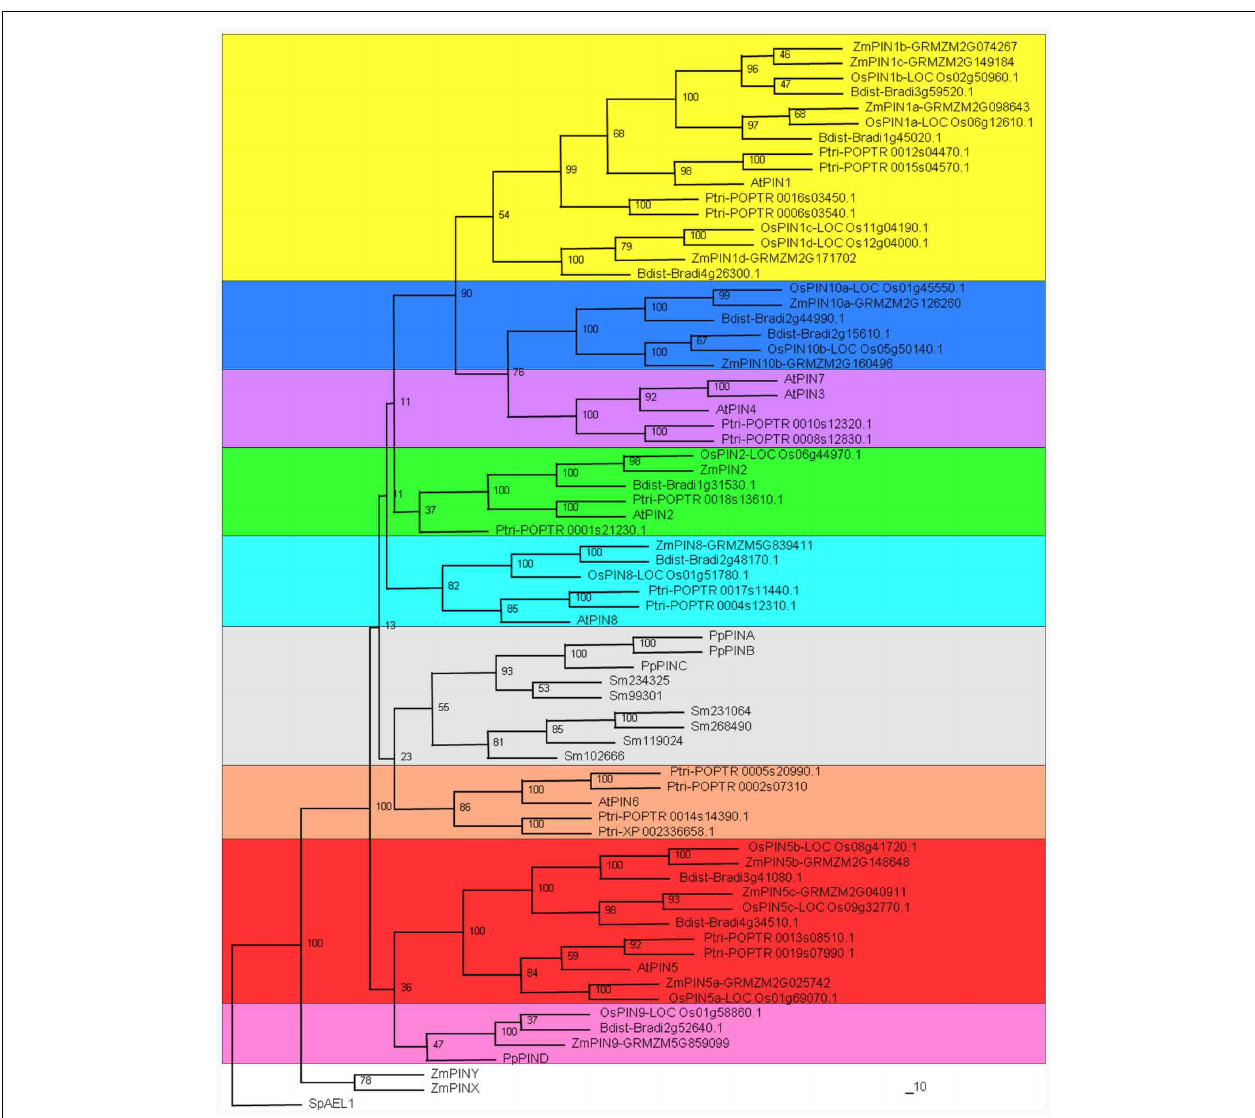
FIGURE 1 | Phylogenetic analysis of PIN auxin efflux carriers from Zea mays , Arabidopsis thaliana , Oryza sativa , Brachypodium distachyon , Populus trichocarpa , Physcomitrella patens , and Selaginella moellendorffii . The phylogenetic analysis between newly identified maize PIN proteins and PINs of eudicots and monocots, summarizes the evolutionary relationships among the 70 members of the PIN protein family. PIN protein sequences of Z. mays ( Zm ), A. thaliana ( At ), P. trichocarpa ( Ptri ), O. sativa ( Os ), B. distachyon ( Bdist ), P. patens ( Pp ), and S. moellendorffii ( Sm ) were retrieved by family blast searches in